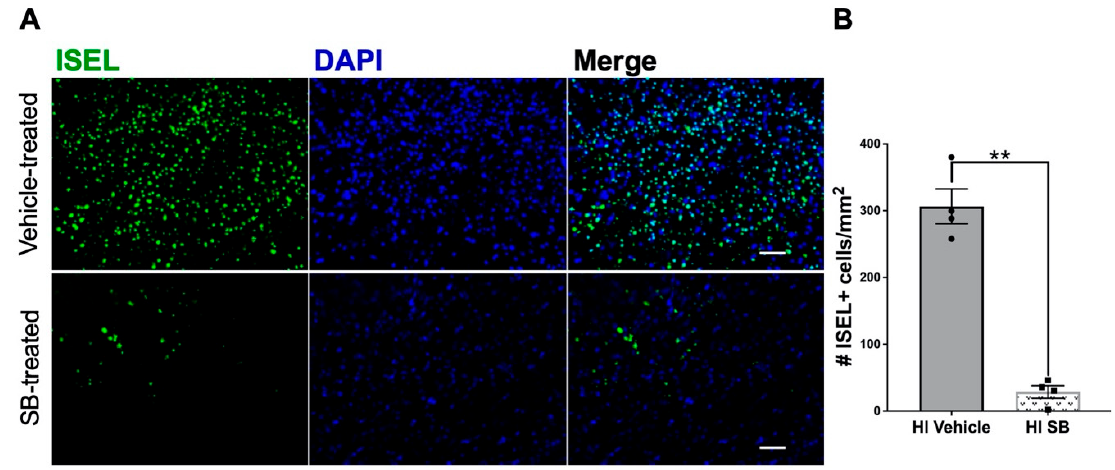
Figure 1. SB505124 diminished the number of actively apoptotic cells in the neocortex after hypoxia-ischemia (HI) injury. One week after HI injury at P6, samples of the injured forebrain were analyzed for actively dying cells using in situ end labeling (ISEL). SB505124 or vehicle was administered via osmotic pump beginning at three days after injury and maintained for four days prior to intracardiac perfusion. Thirty μ m sections were processed for ISEL. Cells with green nuclei indicate nicked DNA strands. ( A ) Panels depict representative neocortical cells in the ischemic penumbra of injury in vehicle-treated and SB505124-treated animals. Scale bars in merged image represent 20 μ m. ( B ) Quantitative analysis of the number of ISEL+ cells of the neocortex per mm 2 . n = 4 per group. Data are presented as means ± SEM ** p < 0.001 by Student’s t -test.